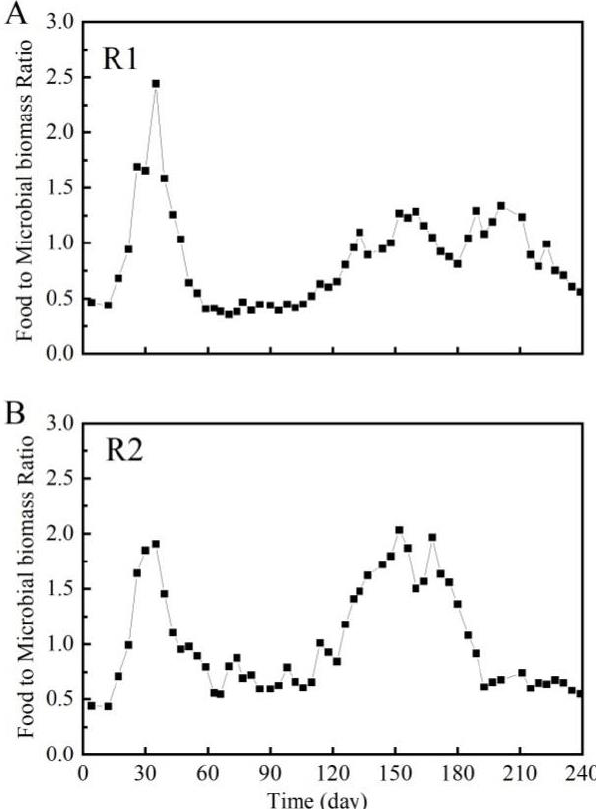
Figure 2. F/M in R1 and R2 throughout the whole operation period. ( A ) for R1; ( B ) for R2.